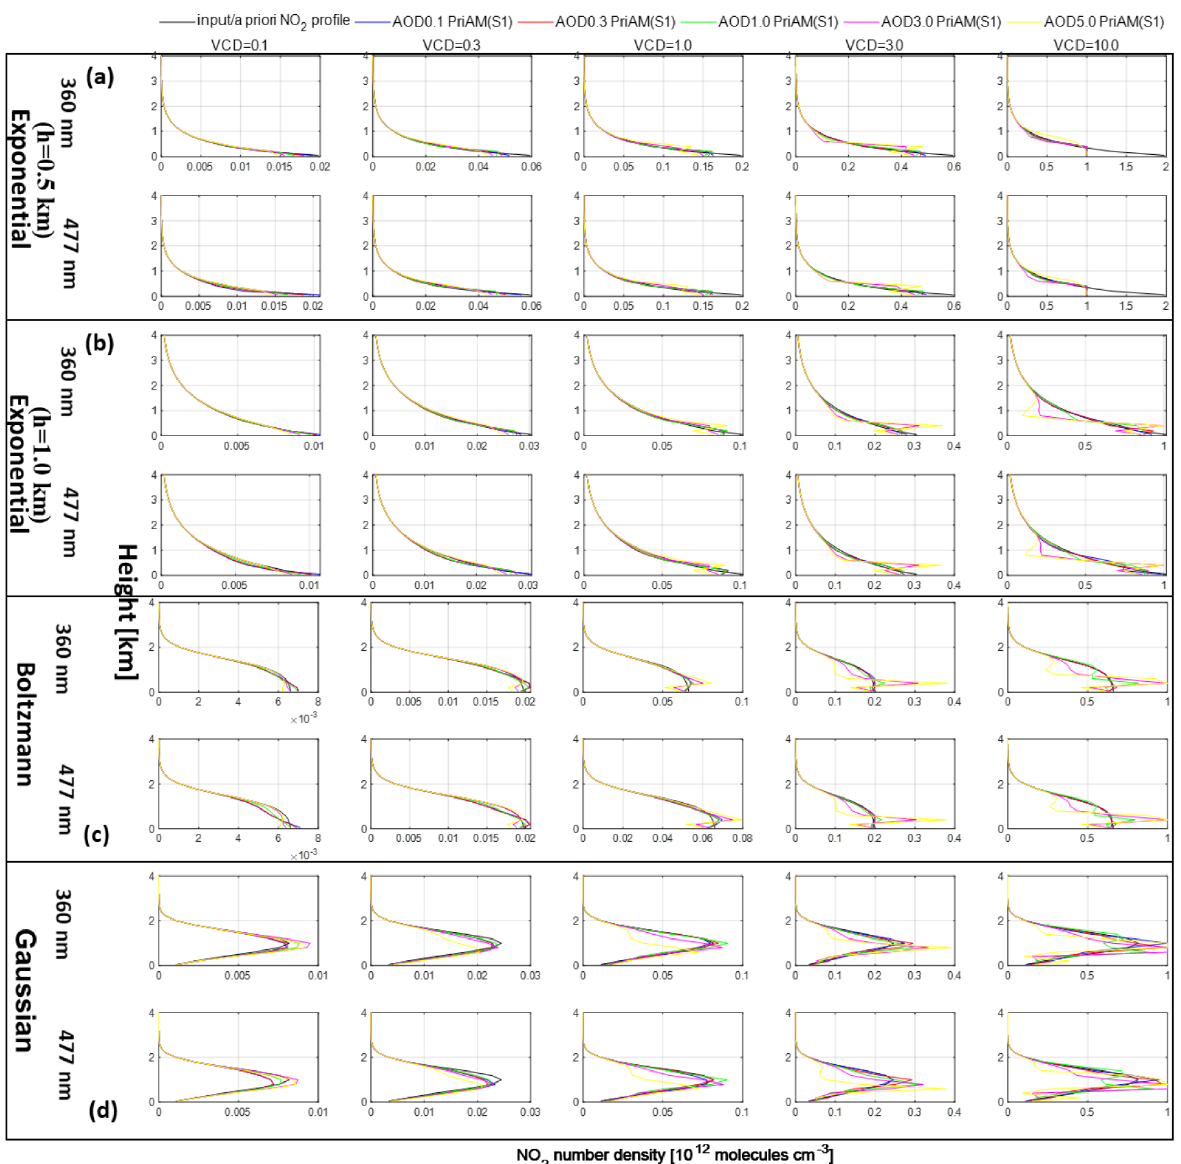
Figure 16. Retrieved NO 2 profiles by PriAM if exactly the a priori profiles for aerosols and NO 2 are used as input profiles (for scenario S1; see text) for aerosol profiles with five AODs (0.1, 0.3, 1.0, 3.0, and 5.0) and five NO 2 VCDs for of (a) exponential shape with h = 0.5km, (b) exponential shape with h = 1.0km, (c) Boltzmann shape, and (d) Gaussian shape. The solid colored lines refer to the AODs and algorithms shown at the